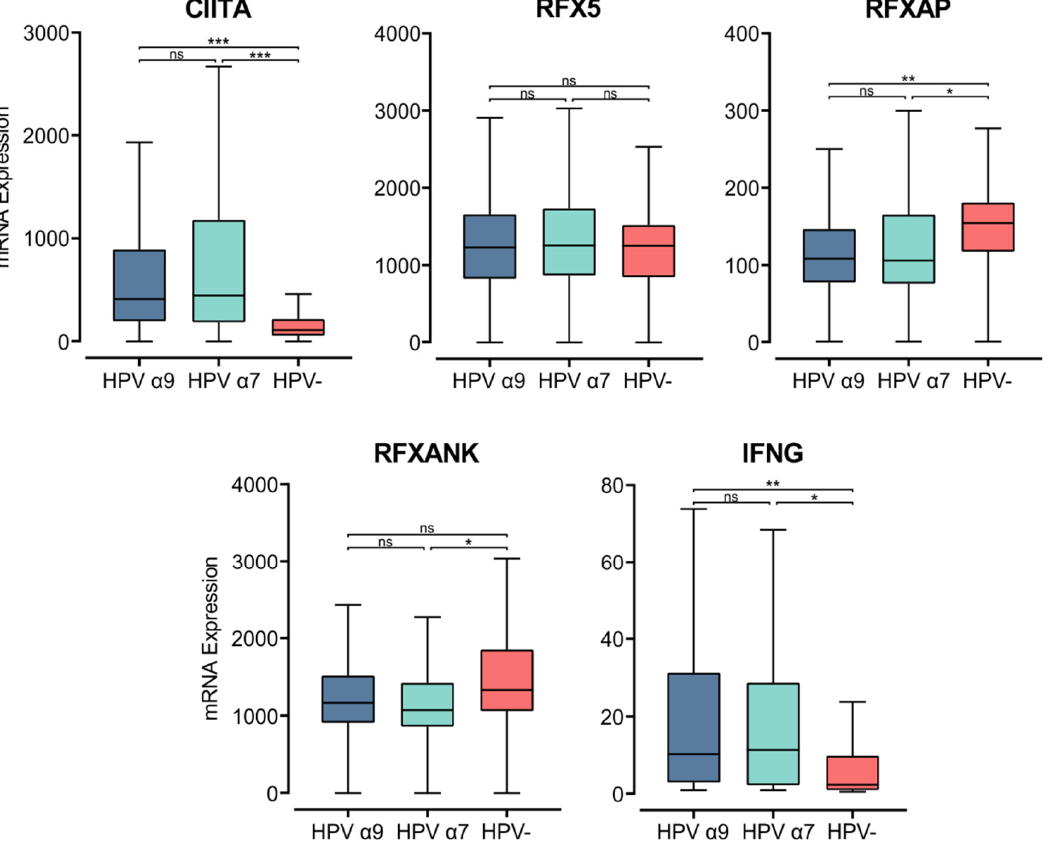
Figure 3. Expression of transcriptional regulators of MHC class II and IFN γ in CC stratified by HPV+ ( α 9 or α 7) and HPV − status. Normalized RNA-seq data for CIITA , genes encoding for the RFX family of transcription factors, and IFN γ were extracted from the CC cohort of the TCGA database. *** p ≤ 0.001, ** p ≤ 0.01, * p ≤ 0.05, ns (not significant).